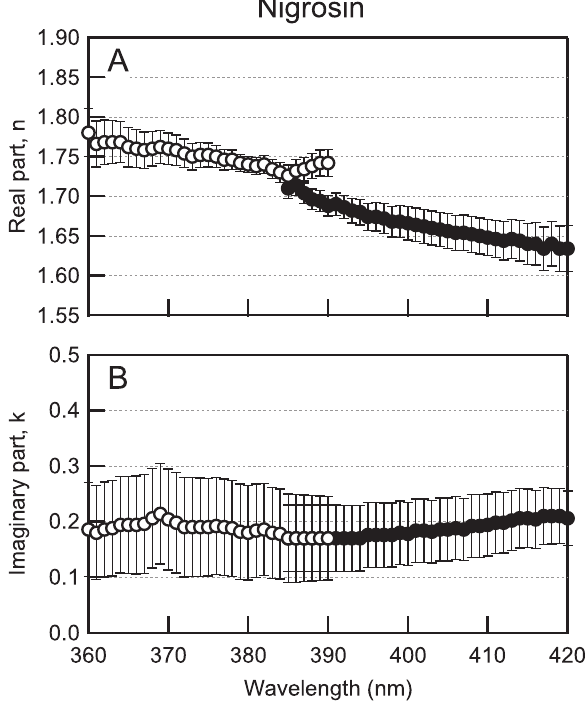
Fig. 8. (a) The real part of the complex refractive index (RI) as a function of wavelength for nigrosin aerosol. (b) The imaginary part of the